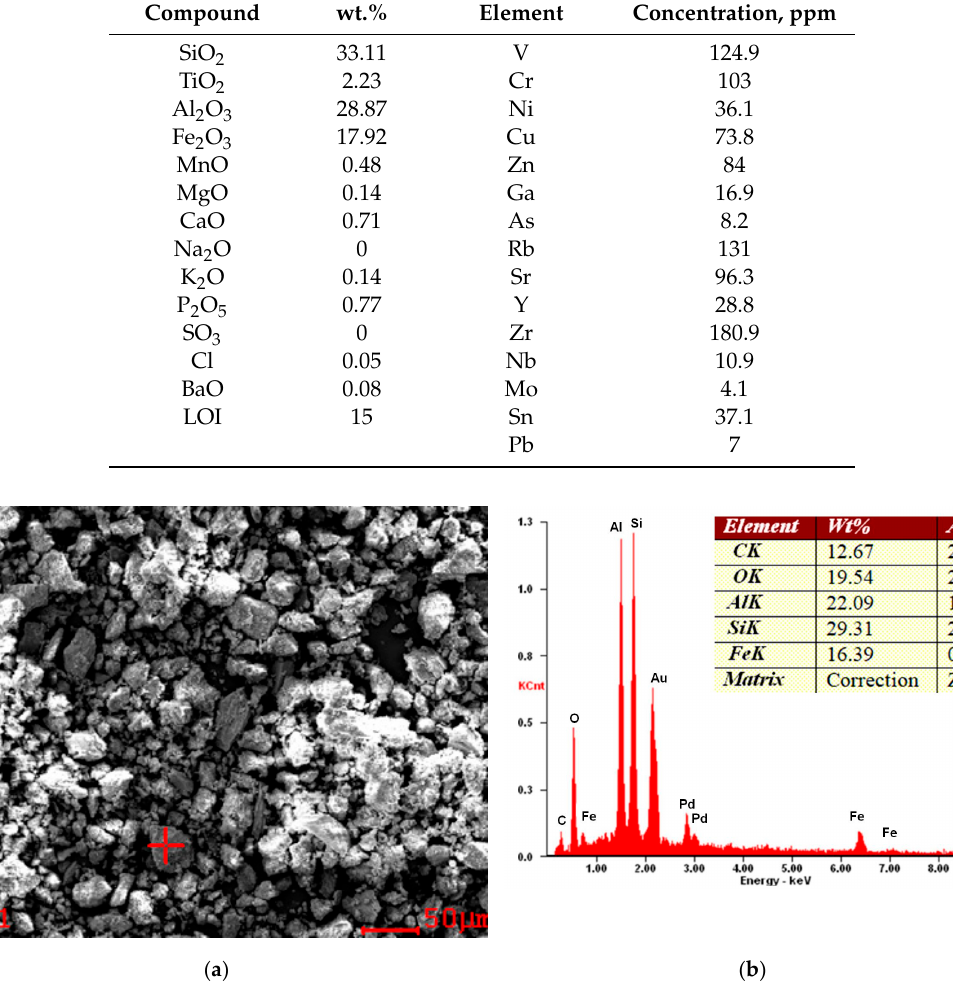
Figure 4. Example of SEM micrograph ( a ) and EDS spectra ( b ) of a halloysite sample from the Dunino deposit. The sample was sputtered by an Au/Pd target.